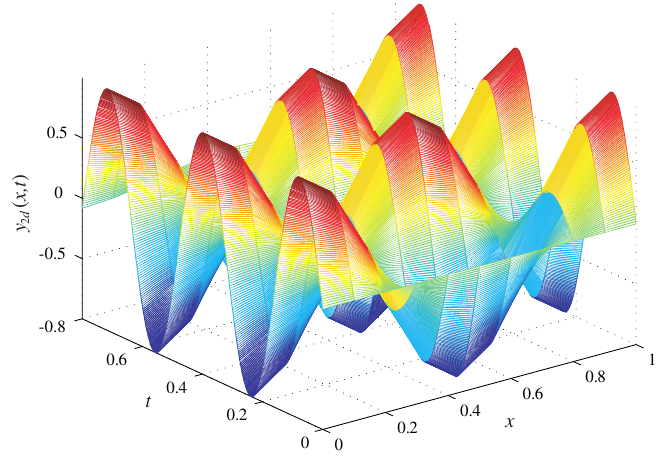
Figure 2. The desired output y 2 d .